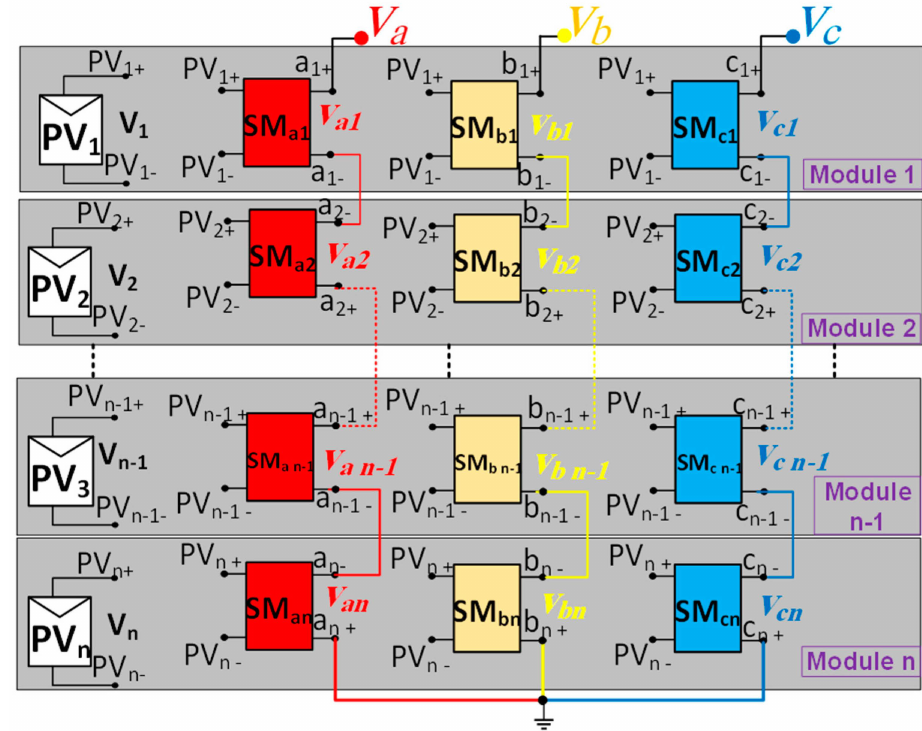
Figure 15. Generic single-stage MMI for large-scale PV applications [27].